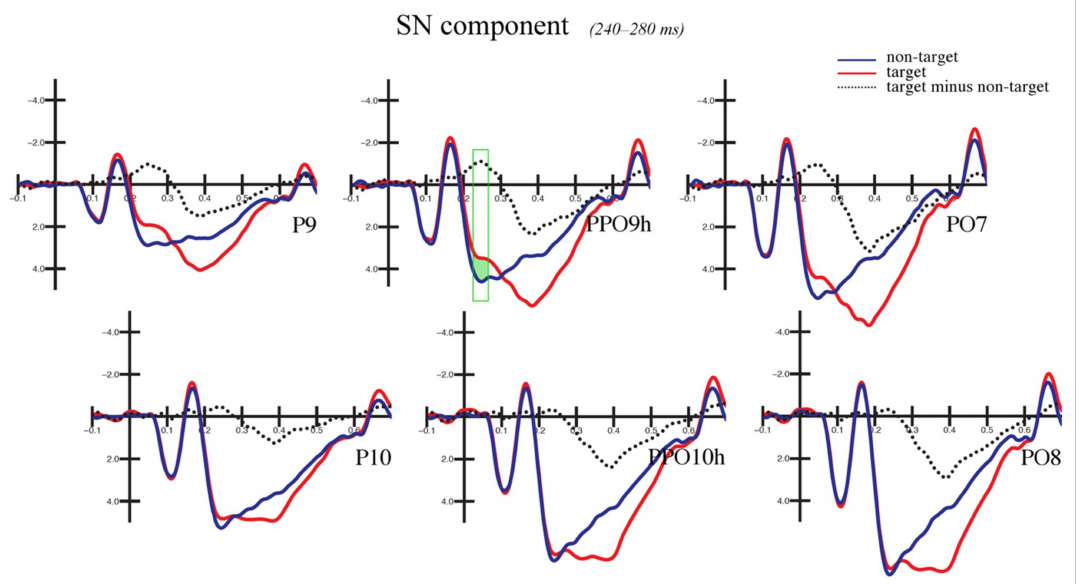
Figure 5. Selection negativity (SN) component: grand average ERP waveforms. The figure illustrates the grand average ERP waveforms recorded at occipito-temporal sites. The correctly recognized targets (in red) relative to non-target stimuli (in blue) led to more negative values of the SN (selection negativity) response between 240–280 ms (area highlighted in green, which also corresponds to the area under the dotted curve). The top row shows electrode sites over the left hemisphere (P9, PPO9h, and PO7), while the bottom row shows those over the right hemisphere (P10, PPO10h, and